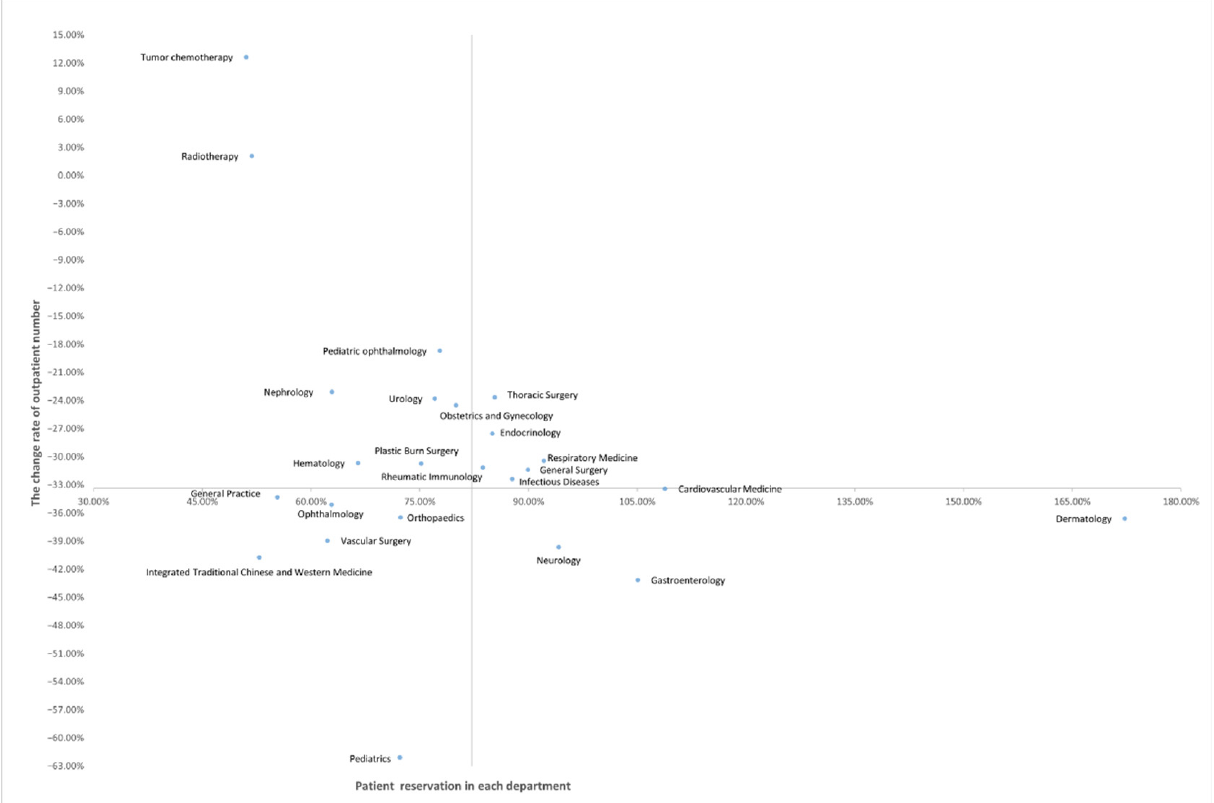
Figure 2. Outpatient doctor resource allocation strategy matrix.